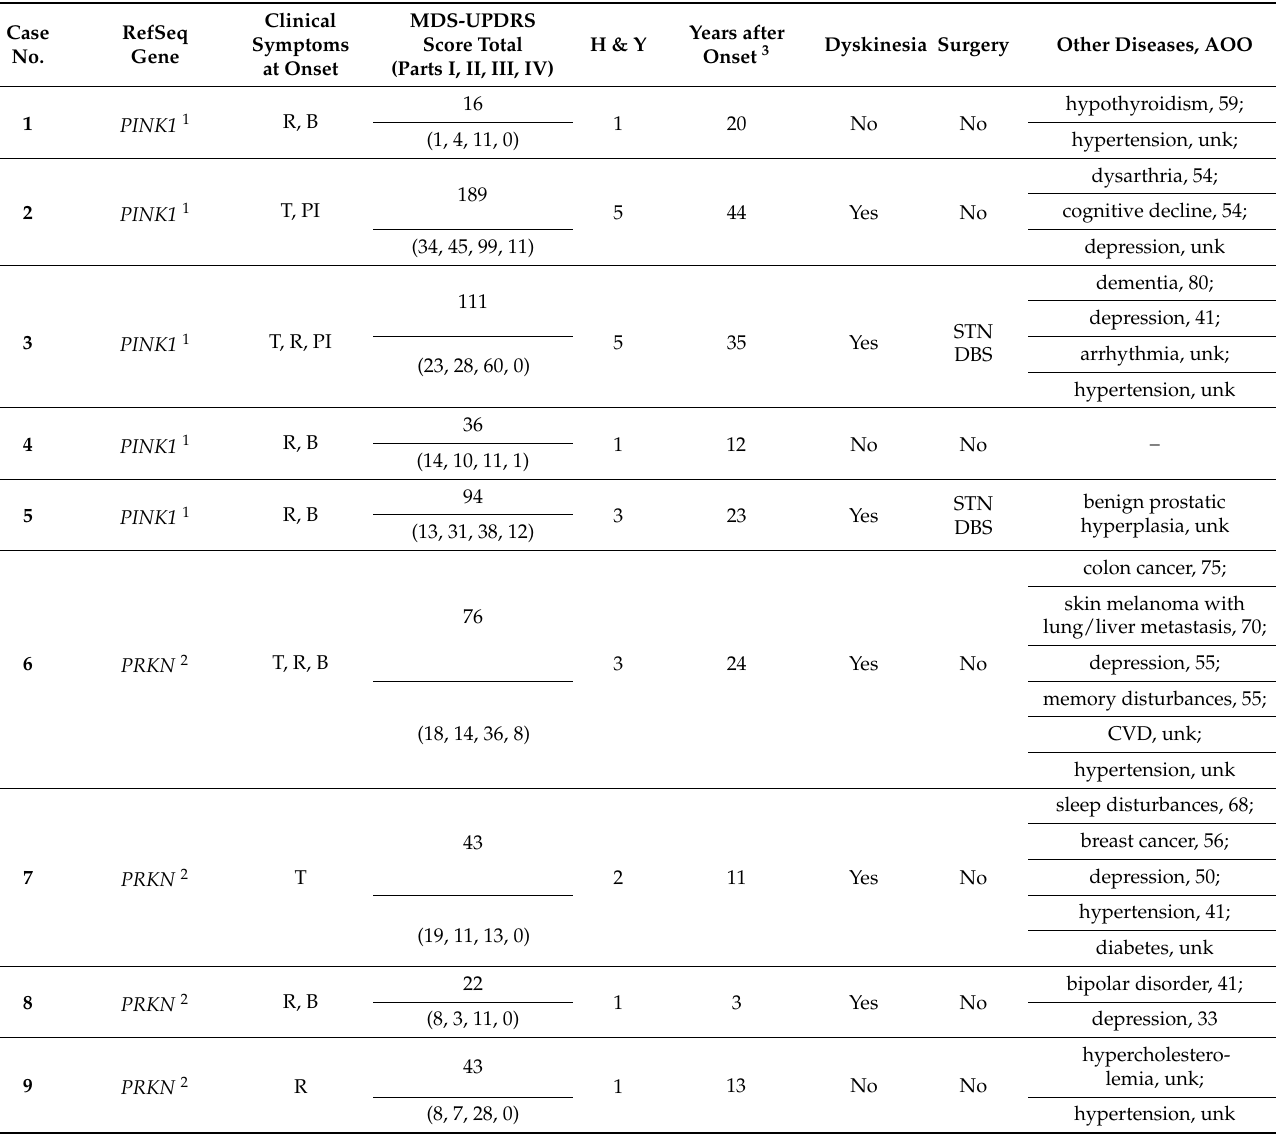
Table 2. Clinical characteristics of patients carrying a pathogenic